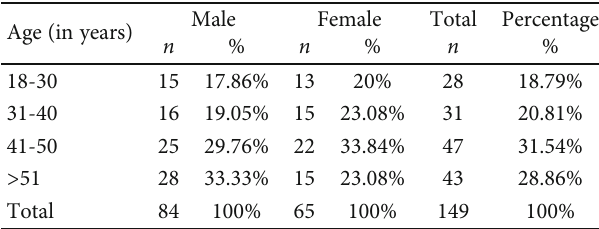
Table 1: Socio-demographic distribution of patients taking beta- blockers in the medical wards of NGH within 2